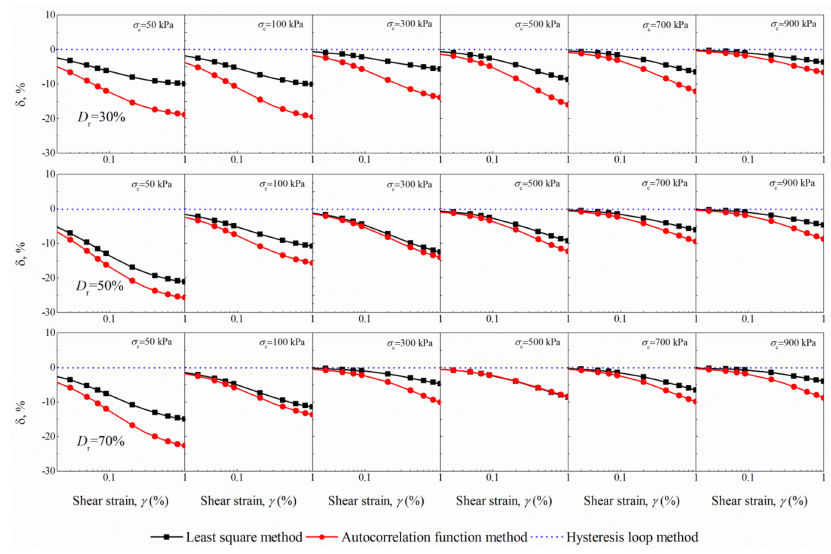
Figure 12. Percentage changes in G / G max for two determination methods ( D r = 30, 50, 70% and σ c = 50~900